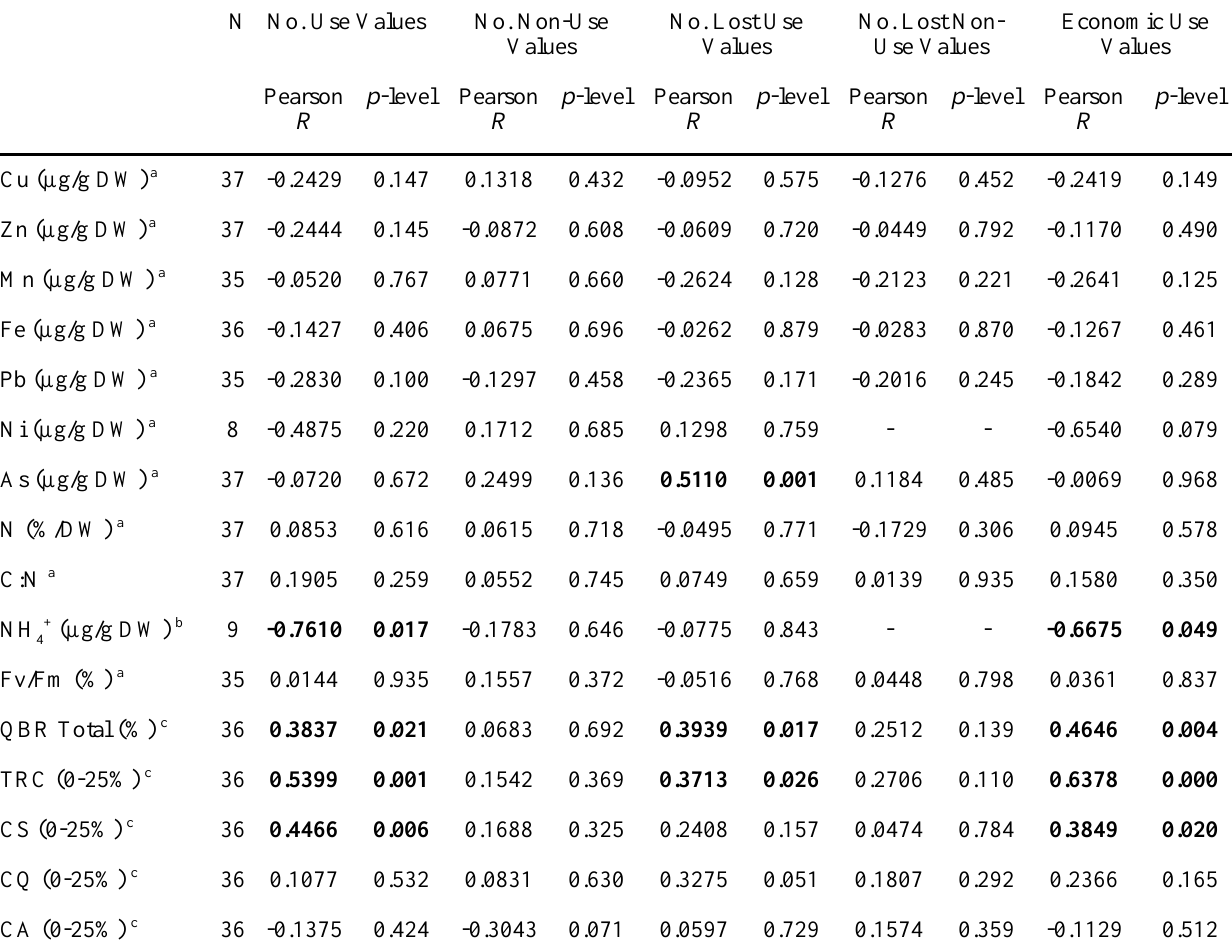
Table 2. Correlation between (i) ecological indicators: concentration of the following elements measured in the mosses: copper (Cu) (µg/g DW), zinc (Zn) (µg/g DW), manganese (Mn) (µg/g DW), iron (Fe) (µg/ g DW), lead (Pb) (µg/g DW), nickel (Ni) (µg/g DW), arsenic (As) (µg/g DW), total nitrogen (N)